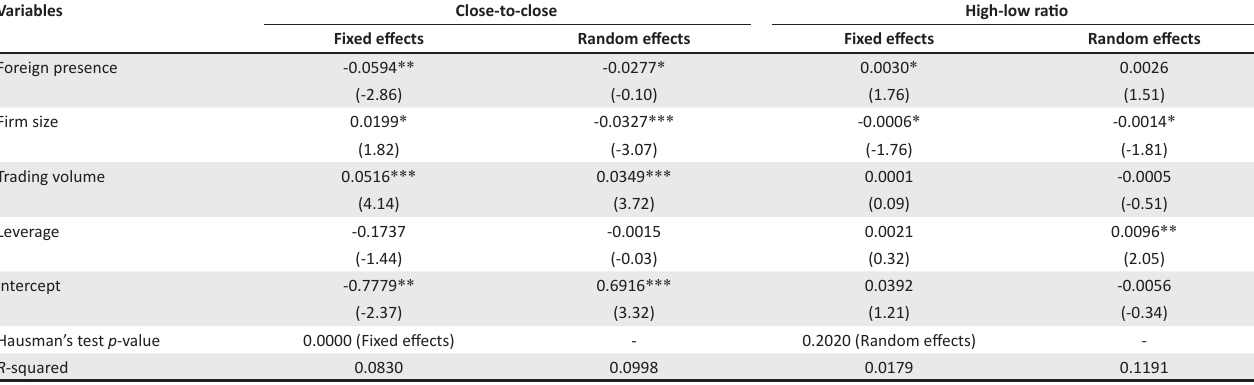
TABLE 4: Volatility changes around event date – Unmatched sample. Variables